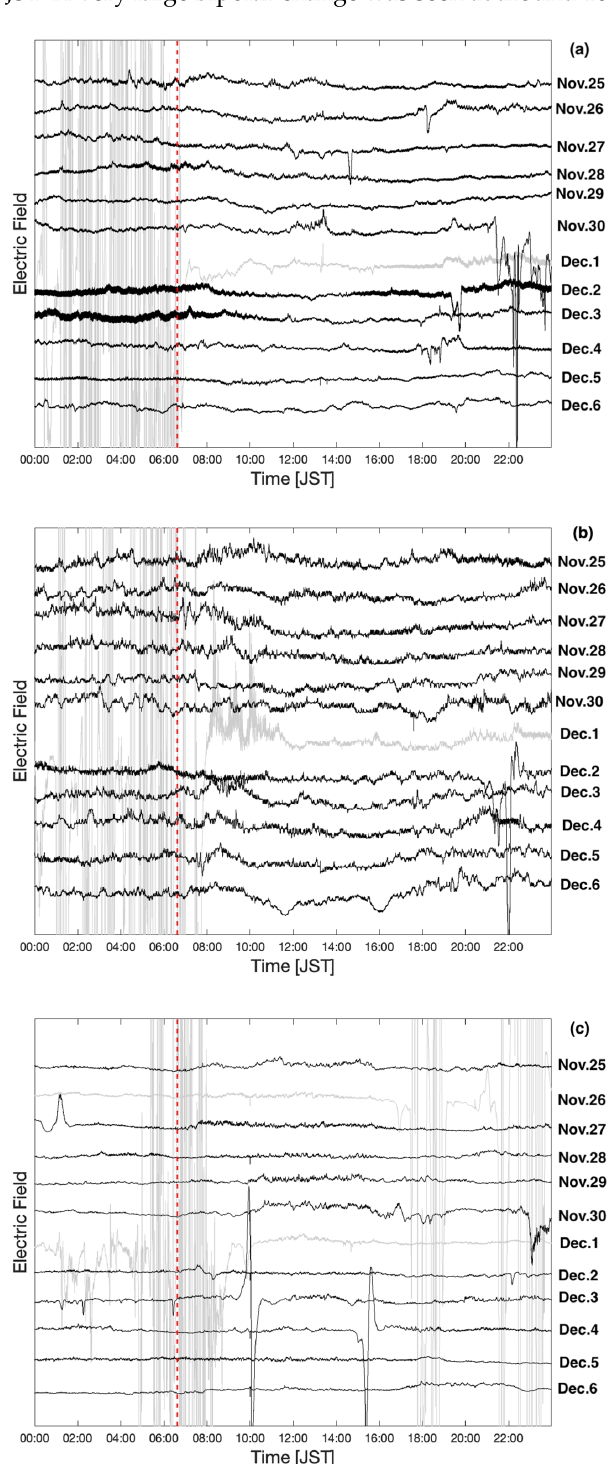
Figure 2. Daily time series of the AEF from 8 days before up to 3 days after EQ1 on 3 December: ( a ) Chofu (CHF), ( b ) Kakioka (KAK), and ( c ) Iwaki (IWK). Heavily disturbed days due to bad local weather conditions are shown as gray curves.